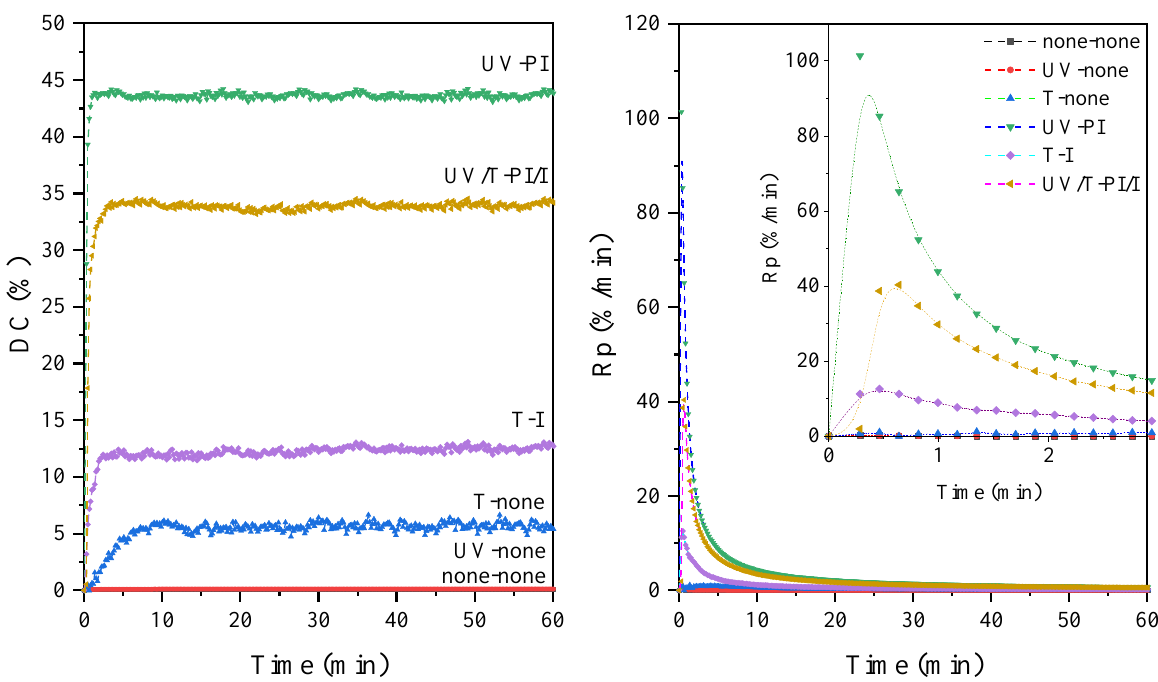
Figure 7. The unsaturated double bond conversion (DC) and the polymerization rate (Rp) of 2DB-UA resin with respect to the curing method.